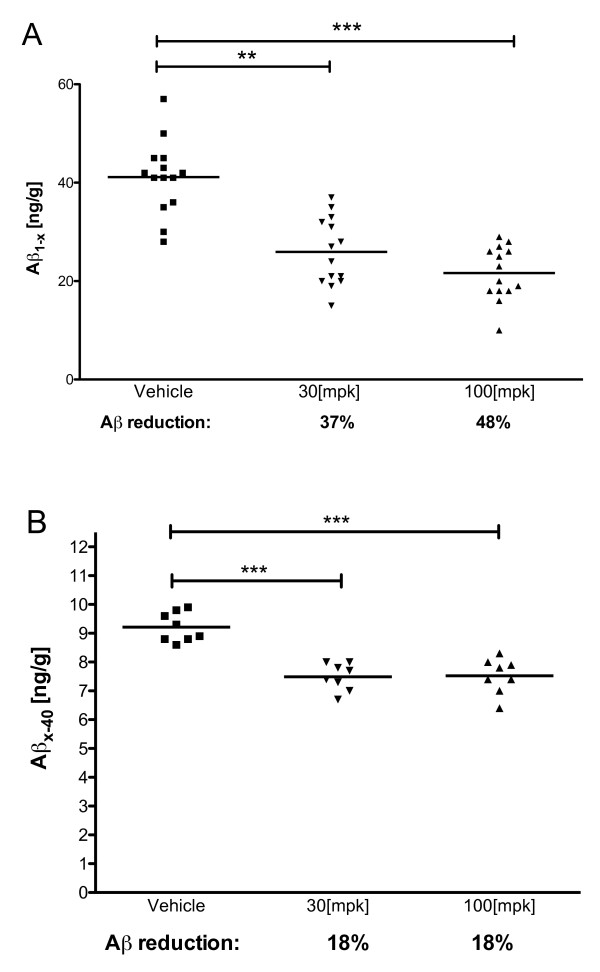
Acute reduction of brain Aβ by ELN318463 in PDAPP (a) and FVB mice (b). The mice were dosed orally with vehicle, or ELN318463 at 30 mg/kg or 100 mg/kg and sacrificed 3 h post treatment. Brain Aβ1-x in PDAPP (a), or Aβx-40 in FVB (b) was quantified by ELISA following extraction in guanidine buffer as described in methods. ** denotes P < 0.01, *** denotes P < 0.001 by Mann-Whitney in A, and two-tailed Students t-test in (b).